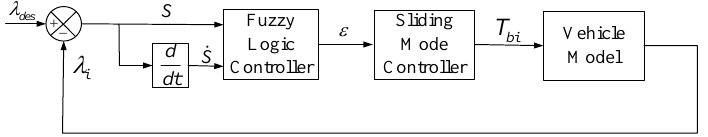
Figure 5. Principle of the fuzzy sliding mode controller